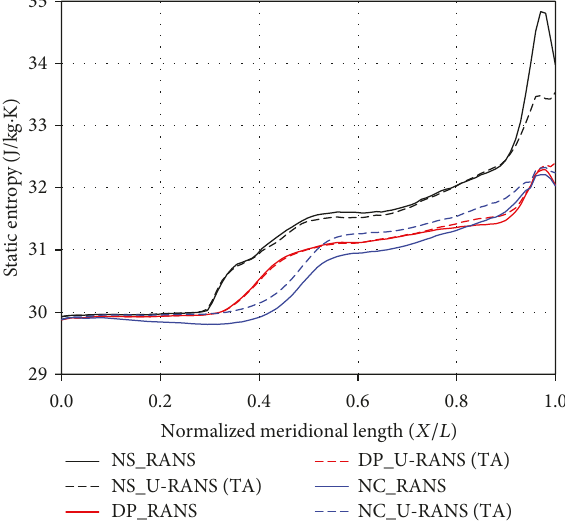
Figure 13: Static entropy distribution in the impeller.